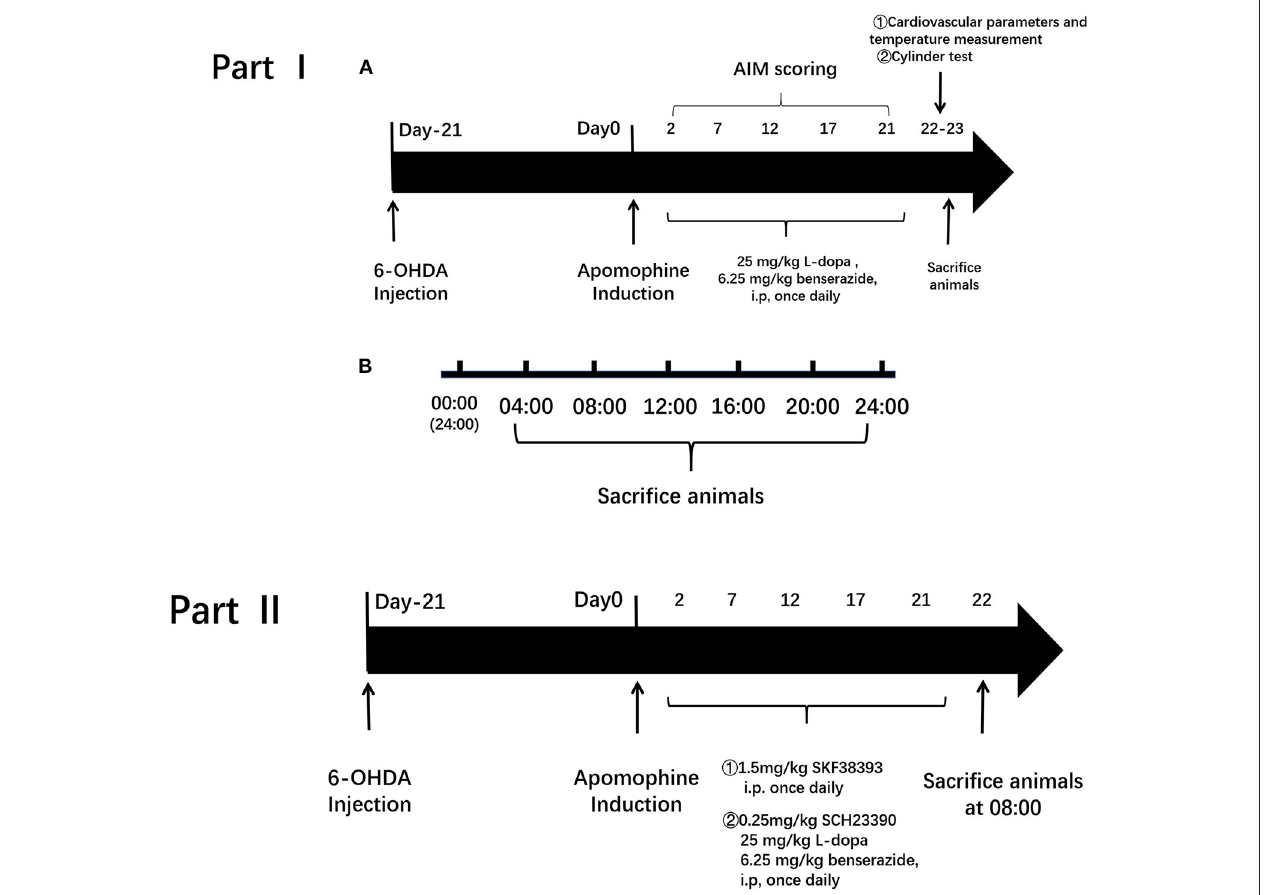
FIGURE 1 | Experimental protocol. The experimental design was divided into two parts. Part I is to investigate the influence of L-3,4-dihydroxyphenylalanine (L-dopa) on circadian rhythms at the molecular level in the Parkinson’s disease (PD) model. Group: (1) 6-hydroxydopamine (6-OHDA)-lesioned group; (2) 6-OHDA-lesioned + L-dopa group; (3) the sham group. Part II is to determine whether the D1R-ERK1/2-mTOR pathway was involved in the alterations of core clock protein induced by L-dopa. Group: (1) 6-OHDA-lesioned group; (2) 6-OHDA-lesioned + L-dopa group; (3) SKF38393 group; (4) SCH23390 group (SCH23390 + L-dopa + benserazide); (5) the sham group.